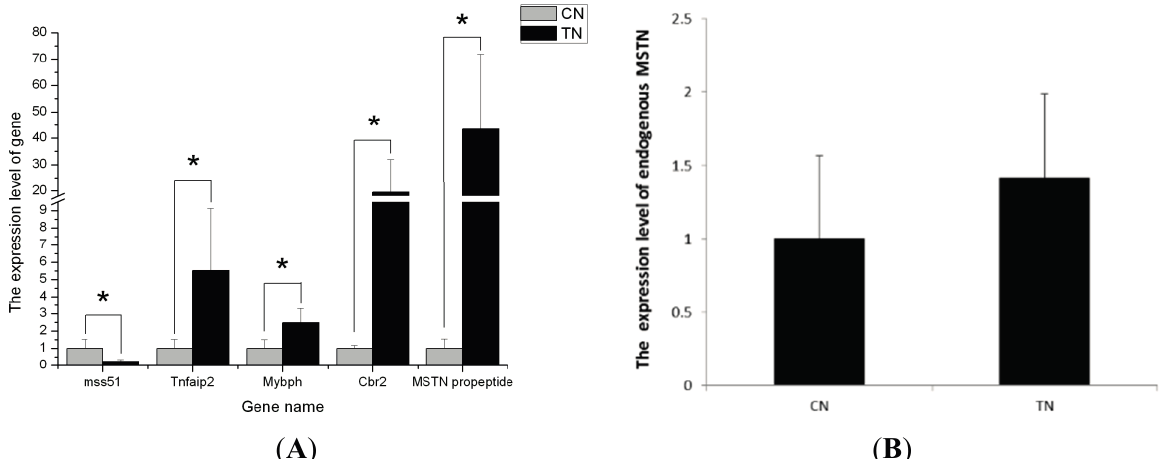
Figure 4. Q-PCR validation of genes from RNA-seq results between MSTN propeptide transgenic and control mice. All samples were normalized to 18S RNA. ( A ) Tnfaip2, Mybph, Cbr2 and MSTN propeptide were highly expressed in transgenic mice (TN) compared with control mice (CN). Mss51 had lower expression in transgenic mice (TN) compared with control mice (CN); ( B ) Endogenous myostatin ( C -terminal mature peptide) mRNA levels in transgenic mice was slightly higher than the controls, but not significantly different from the control ( p > 0.05). The error bars show the SD. Two-tailed t -test was used